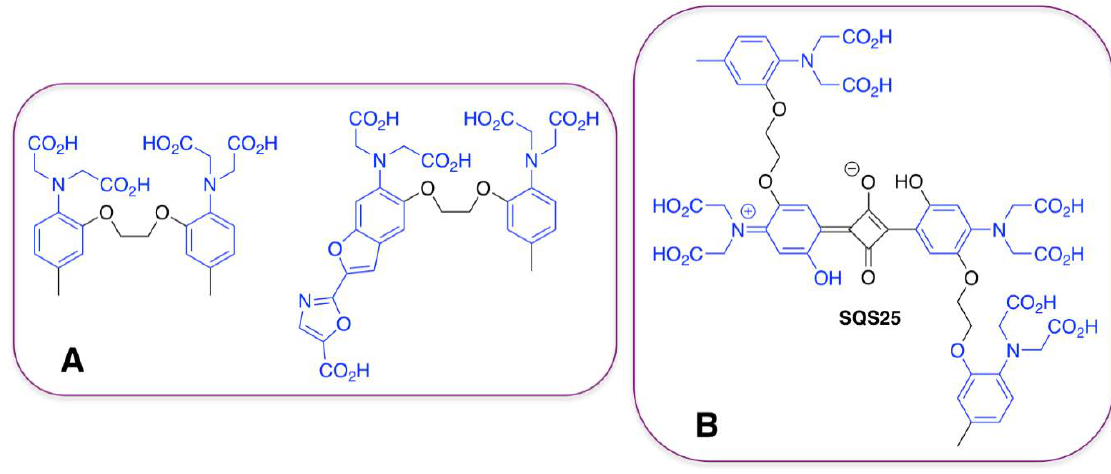
Figure 5. Structures of Ca-specific sensors. ( A ): original Ca indicators; ( B) : squaraine-containing SQS25 [86].